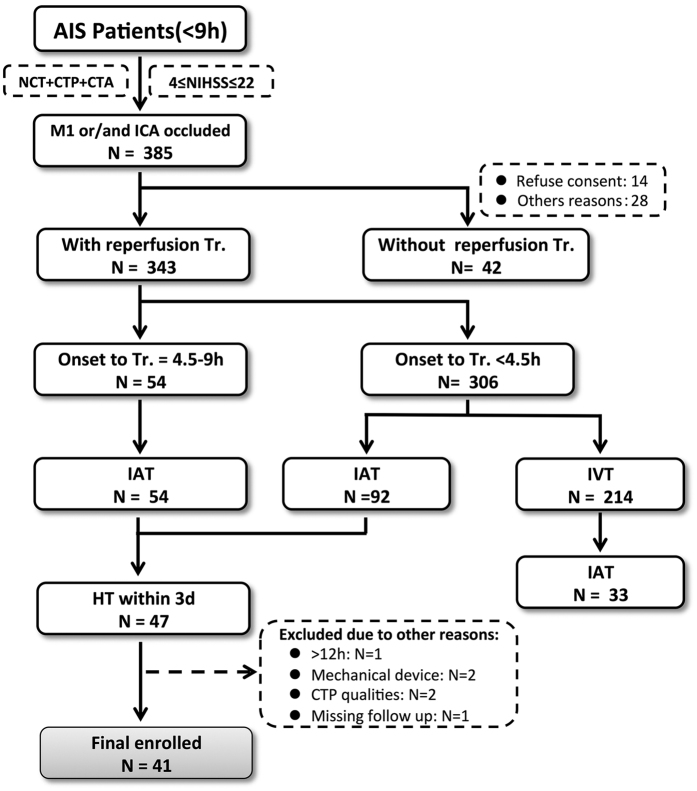
Flow chart outlining patient selection.AIS: acute ischemic stroke, NCT: non-contrast computed tomography, CTP: CT perfusion, CTA: CT angiography, NIHSS: National Institutes of Health stroke scale, M1: the M1 segment of the middle cerebral artery, ICA: internal carotid artery, Tr.: treatment, IAT: Intra-arterial thrombolysis, IVT: Intra-venous thrombolysis, HT: hemorrhagic transformation.